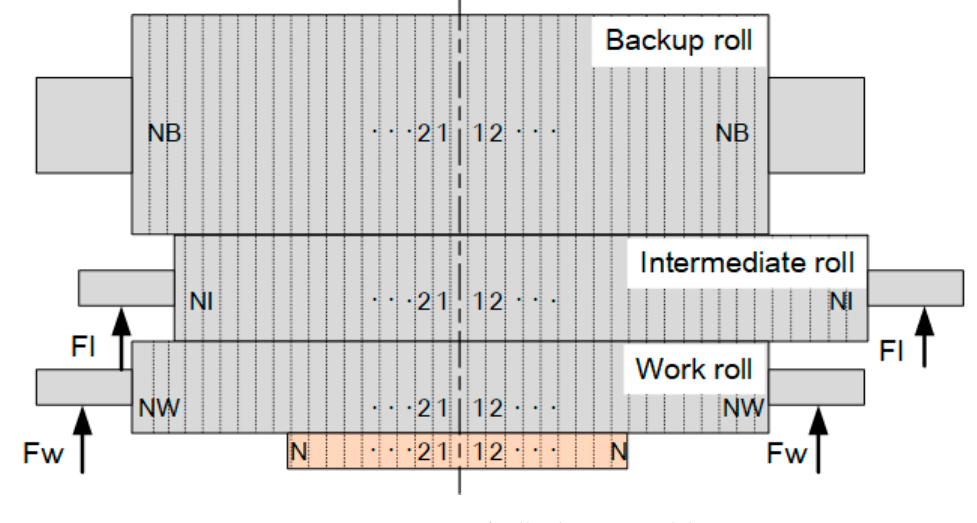
Figure 5. Discrete of rolls element model.